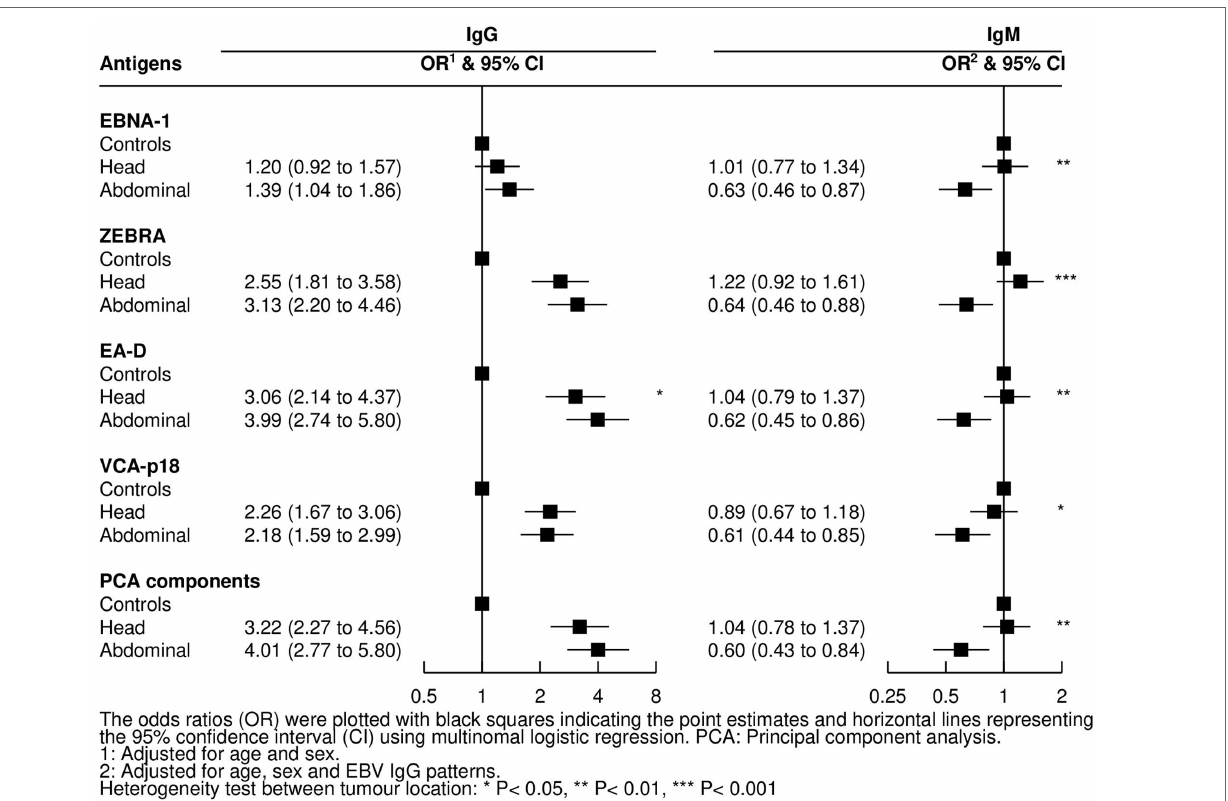
FigUre 6 | Adjusted odds ratios (ORs) and 95% confidence intervals (CIs) for endemic Burkitt lymphoma in relation to IgG and IgM levels against Epstein–Barr virus (EBV) antigens by tumor